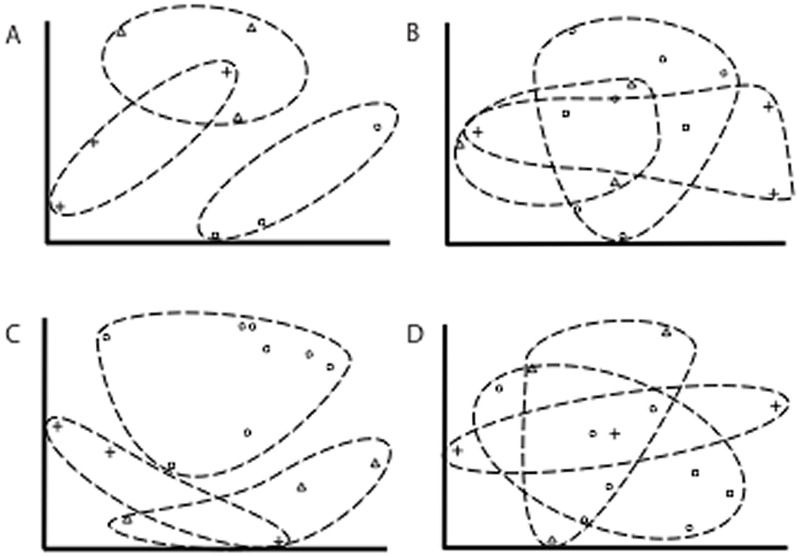
Nonmetric multidimensional plots of bacterial communities.Nonmetric multidimensional plots (three dimensions, stress <0.2; the first two dimensions are shown) based on Yue & Clayton theta (thetayc) similarities of bacterial communities from the small intestine (triangles), large intestine (plus signs), and cloaca (circles) of Agkistrodon piscivorus. Plots are determined from: A) DDGE profiles, B) all OTUs recovered from 454 sequencing, C) dominant OTUs recovered from 454 sequencing (rarest 1% of sequences removed), D) very dominant OTUs recovered from 454 sequencing (rarest 10% of sequences removed). Dashed ellipses indicate groupings based on region of the GIT.